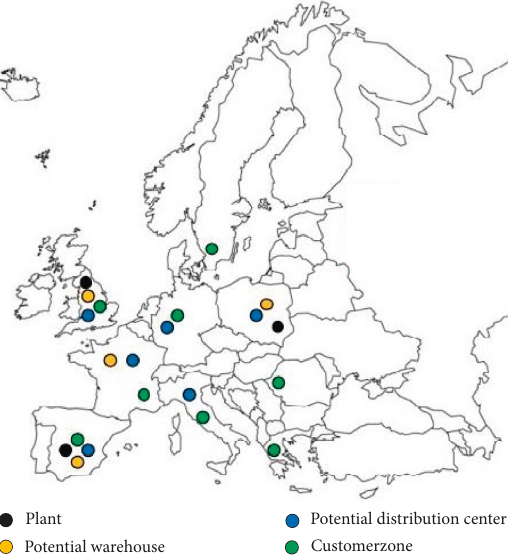
Figure 2: The case study supply chain